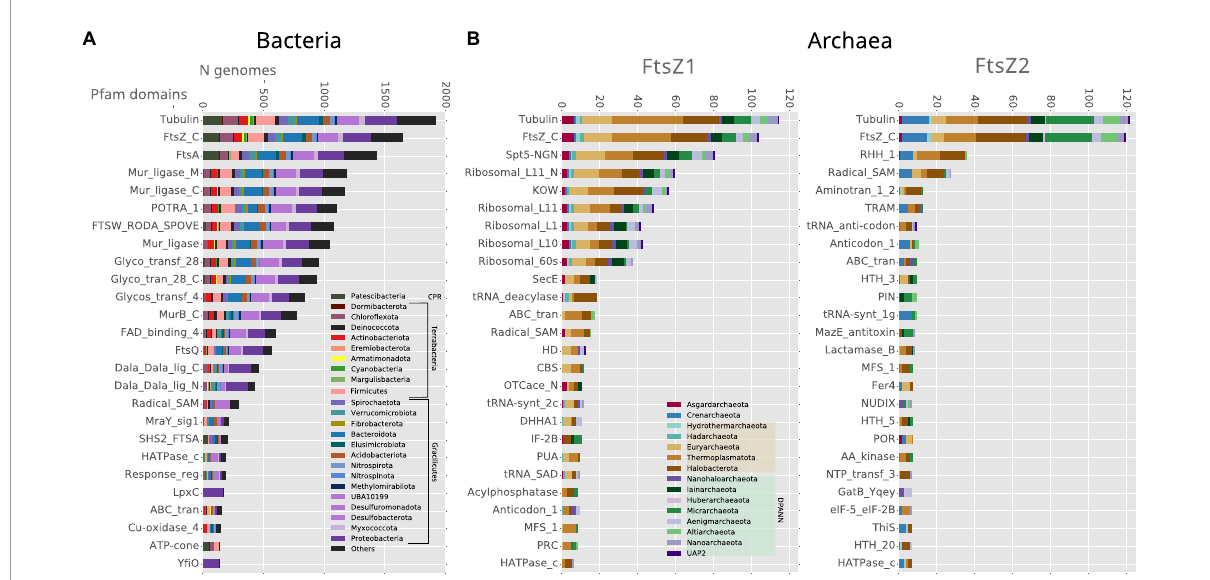
FIGURE3 Genomic context analyses of the prokaryotic ftsZ genes. Analyses of (A) bacterial and (B) archaeal ftsZ genes, showing the 25 Pfam domains most abundant in their genome context; 10 Kb up and downstream of the ftsZ gene. Bars denote the number of genomes of each phylum, having at least one Pfam domain in the respective genome context. Note that some Pfam domains belong to the same proteins, such as Tubulin-FtsZ_C, Potra_1-FtsQ, and